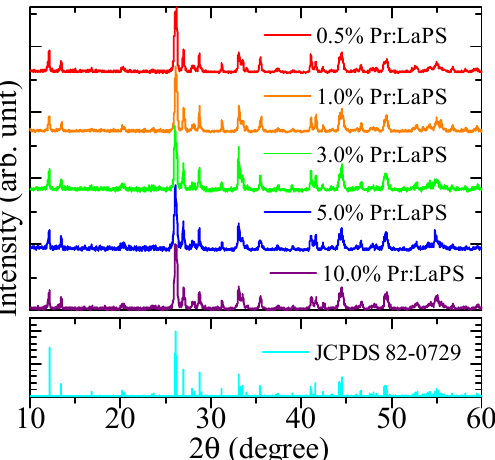
Figure 2. XRD patterns of Pr-doped LaPS samples with the JCPDS 82-0729 reference pattern (La 2 Si 2 O 7 ).